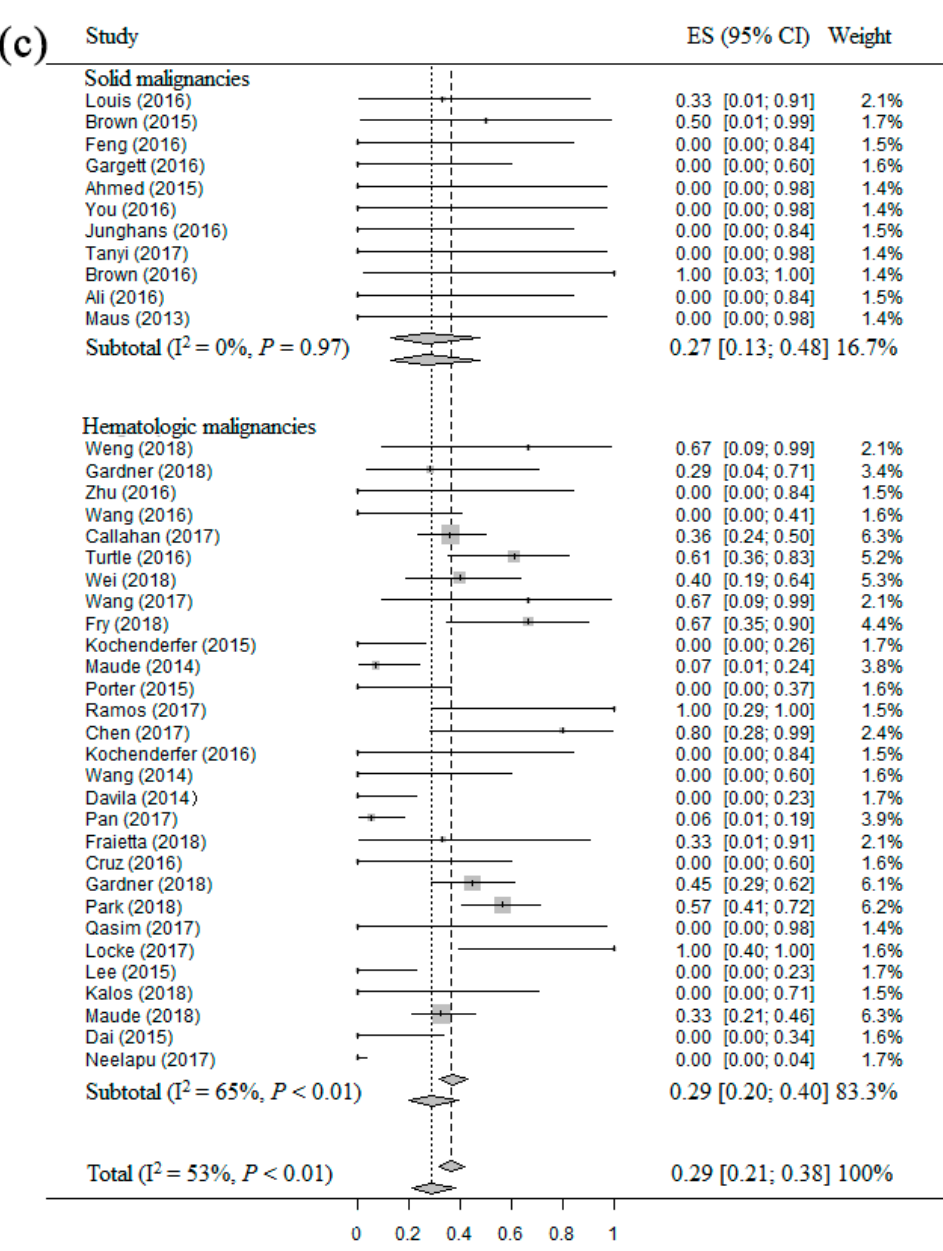
Figure 4. The forest plots of meta-analysis about CSER and RR: ( a ) Forest plot for CRS rate and CI in solid and hematologic malignancies patients of each study and the overall; ( b ) Forest plot for NS rate and CI in hematologic malignancies patients of each study and the overall; ( c ) Forest plot for RR and CI in solid and hematologic malignancies patients of each study and the overall.